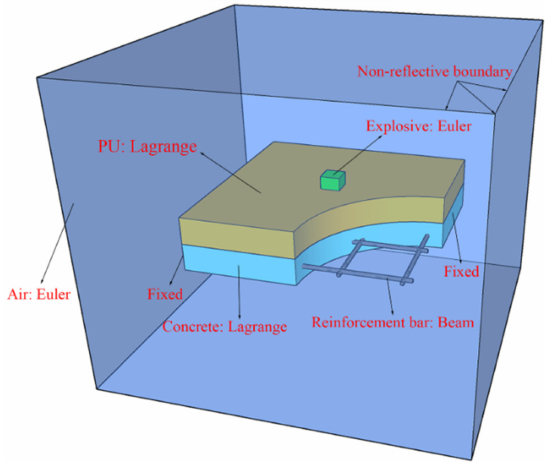
Figure 10. CEL model.